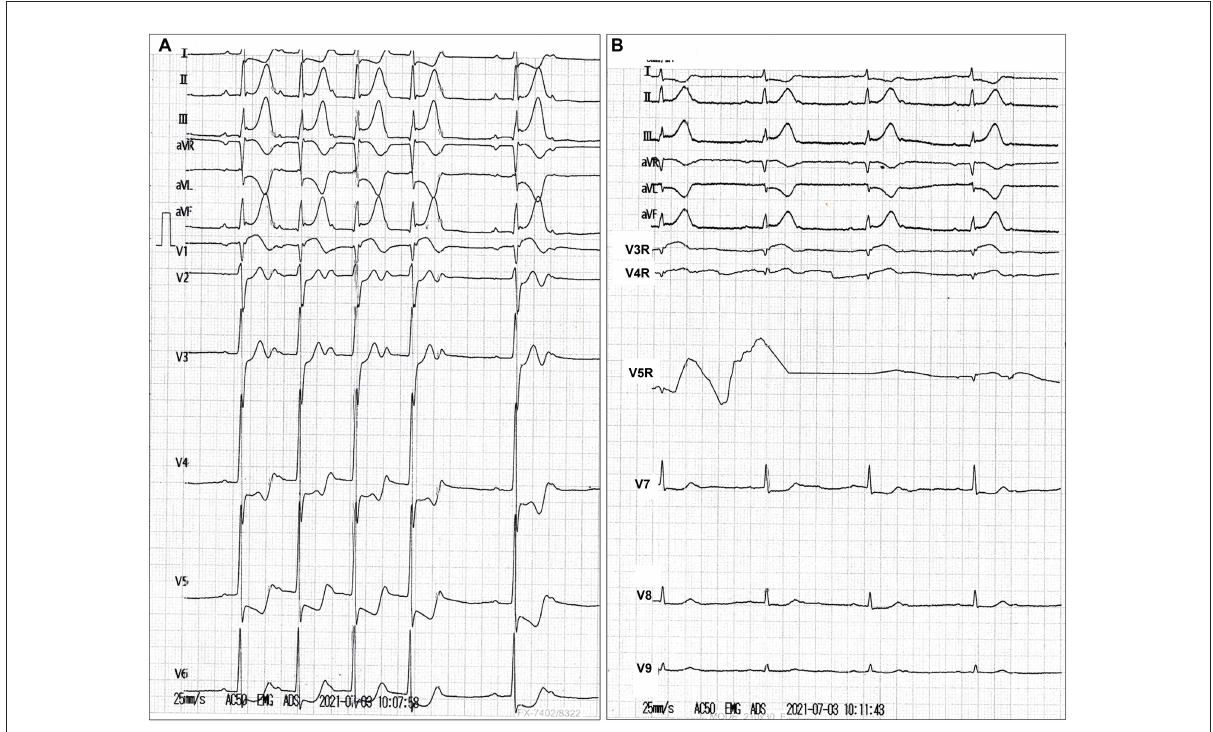
FIGURE1 (A,B) Electrocardiography images.